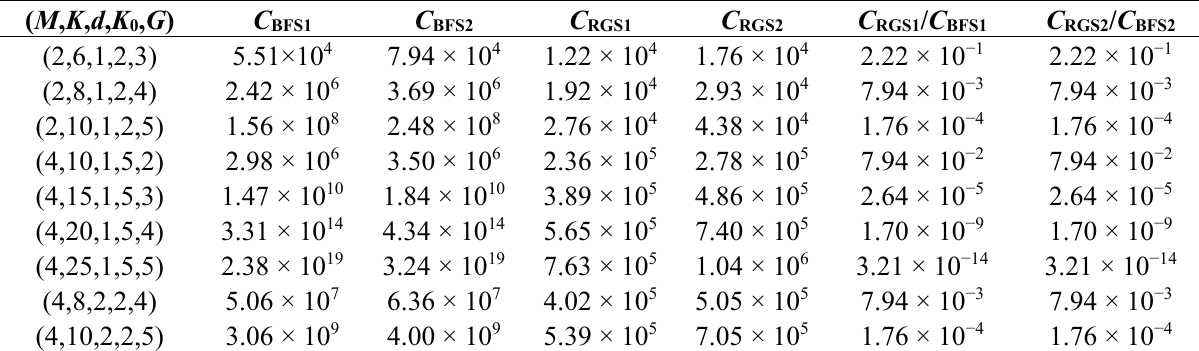
Table 1. The number of overall complex multiplications required by the RGS and BFS algorithms. ( M , K , d , K , G 0